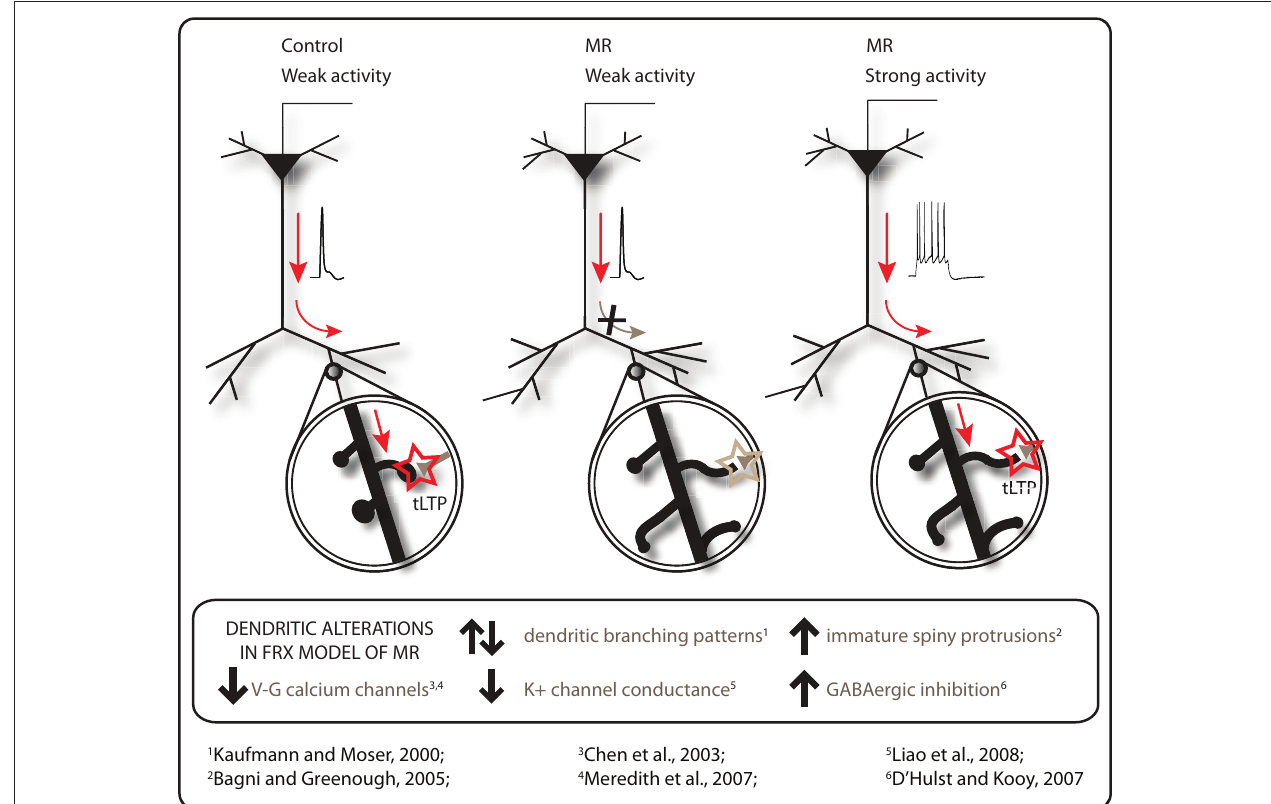
et al., 2007). Abnormalities of dendritic branching patterns and spiny protrusion density and maturity are observed in many forms of MR. A number of candidate mechanisms including down-regulation of calcium channels, increased GABAergic inhibition and alteration of K + conductance affecting function of dendrites and spines may underlie this tLTP deficit to reduce the dendritic excitability in the brain in MR